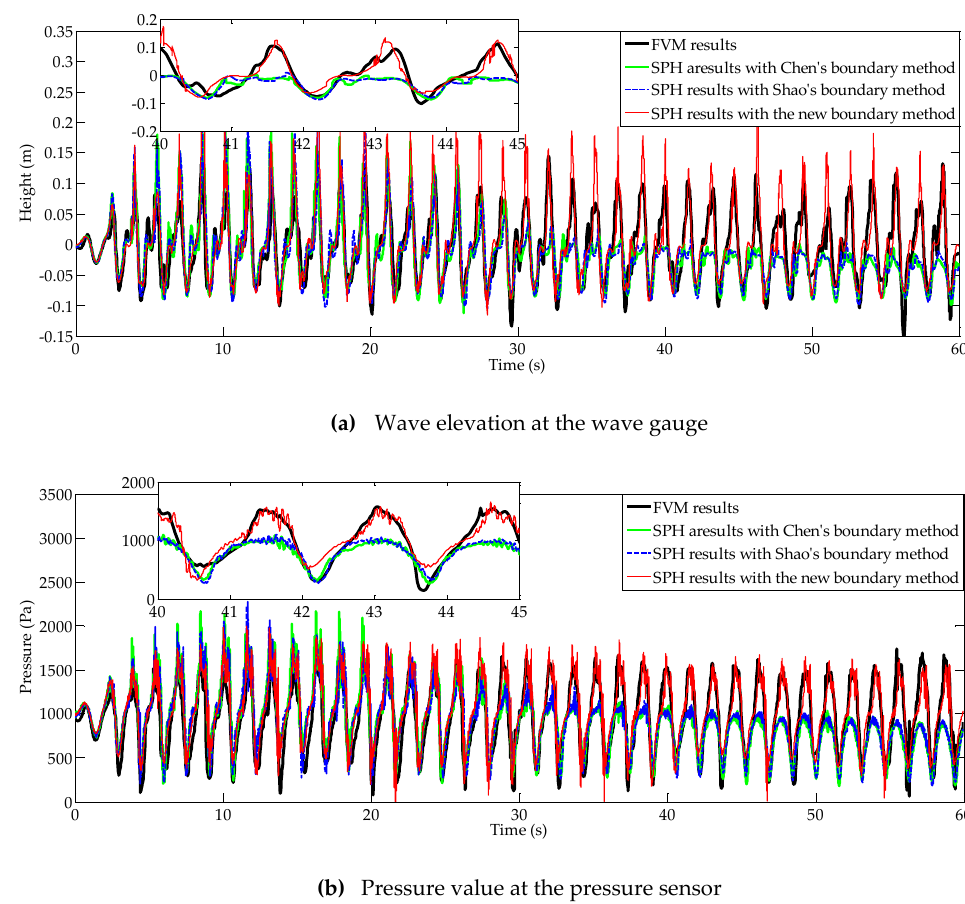
Figure 10. Numerical results obtained by FVM simulation and SPH simulations: ( a ) Wave elevation at the wave gauge; ( b ) Pressure value at the pressure sensor.